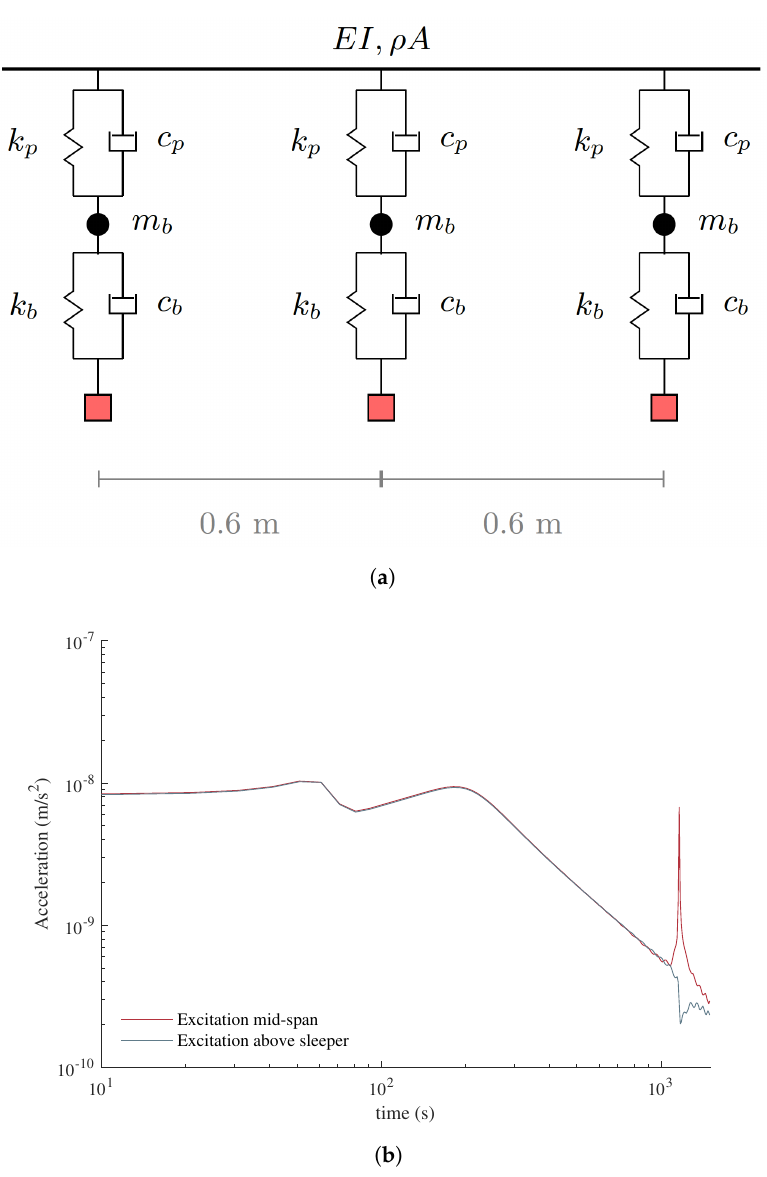
Figure 6. ( a ) Schematic illustration of the track model and ( b ) Receptance test results. Eigen-value analysis on the track-bridge model was conducted to determine the vibra- tion frequencies and the mode shapes of the bridge. Accordingly, the natural frequencies of the first three modes were computed as 1.79 Hz, 6.72 Hz, and 13.30 Hz, respectively. The mode shapes and vibration frequencies are presented in Figure 7.